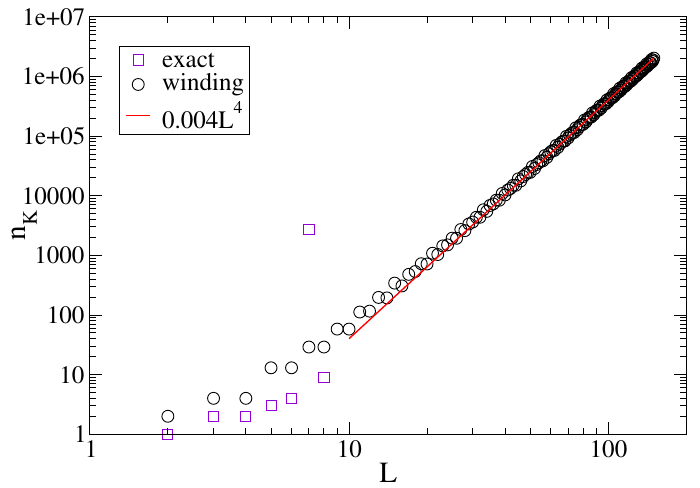
Figure 5: Number of Kempe sectors as a function of linear system size for the coloring problem (squares) and derived by assuming all configurations of winding numbers (circles). They form a finite fraction of the total number of